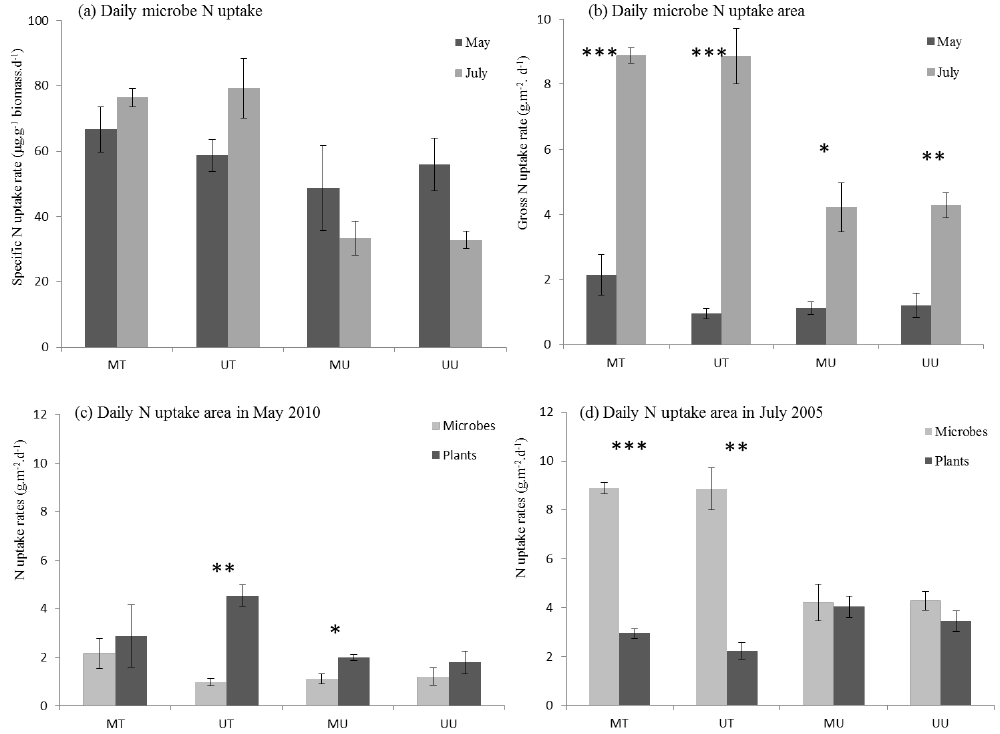
Figure 4. Fig. 4. Differences in soil microbial and plant nitrogen (N) fluxes between the end of snowmelt and the peak biomass in subalpine agricultural grasslands with distinct land uses. The flux of nitrogen (N) into microbial biomass per day is expressed (a) on per-g-biomass basis and (b) on per-area basis. The fluxes of nitrogen (N) into plants (black bars) and microbes (grey bars) are given for (c) May 2010 and (d) July 2005. Uptake of N is calculated from the 15 N concentration and the soil 14 N: 15 N ratio. Data from four 200cm 2 areas per fields were amalgamated to give mean values of three fields per land use ± SE. Statistical analyses were done separately for each land use and stars represent significant differences (* < 0 . 05; ** < 0 . 01 and *** < 0 .